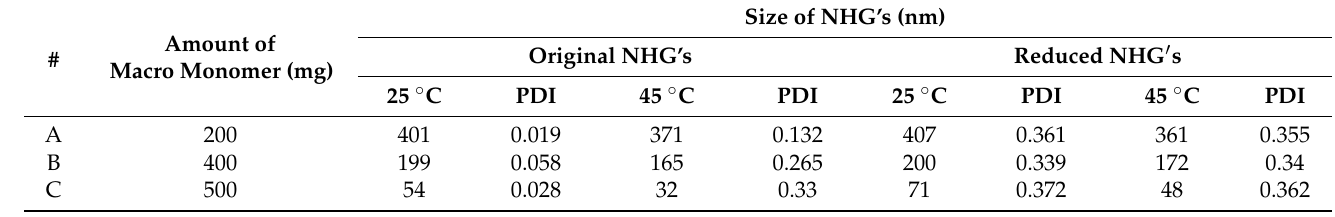
Table 1. Sizes of NHG’s as obtained and after reduction. Results are reported as the mean of 3 measurements. All the polymerizations were performed in 10 mL H 2 O containing 170 mg NIPAAM, Acrylonitrile 60 mg (74 µ L), 5 mg BIS, 5 mg PVP, and 5 mg K 2 S 2 O 8 (KPS). (“Block” refers to (Acr)1.1